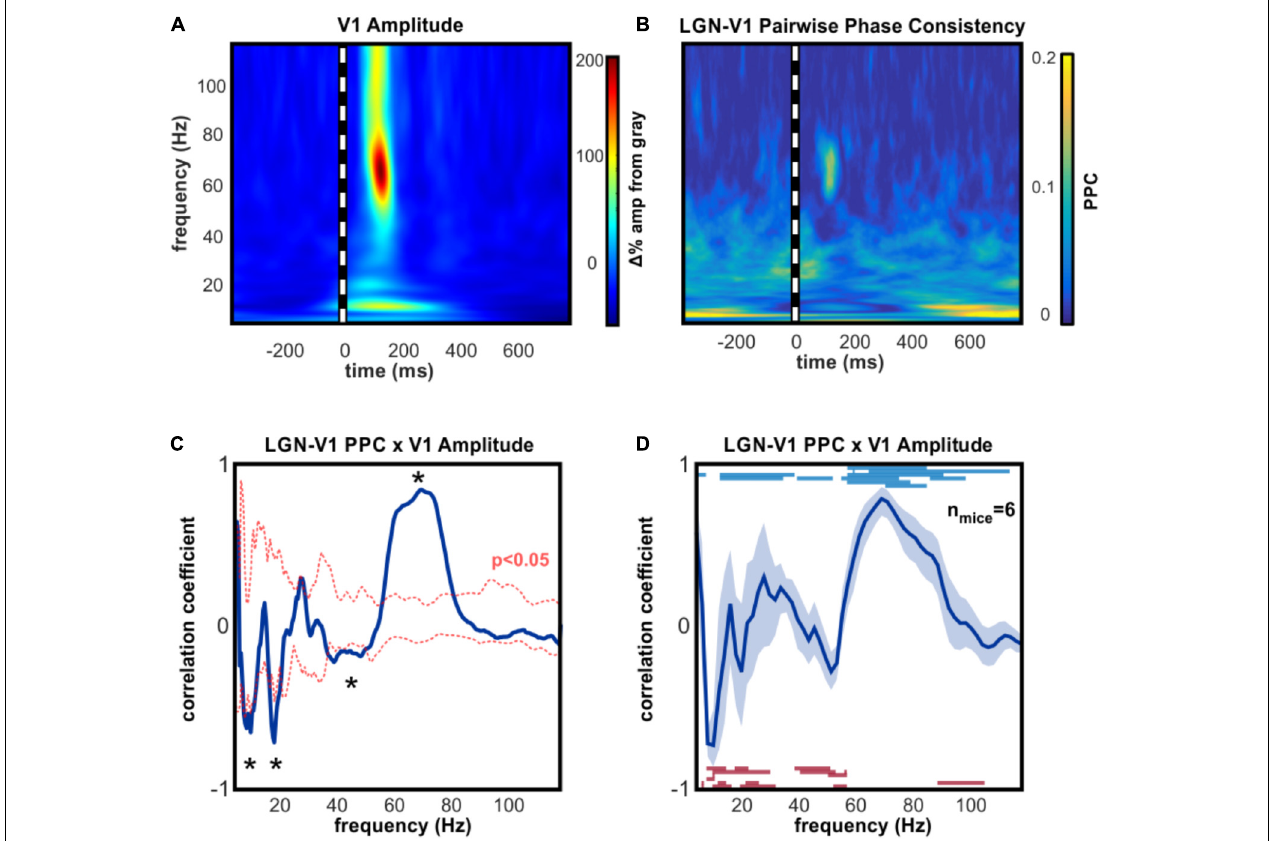
FIGURE 2 | Amplitudeof high gamma V1 oscillations is linked to simultaneous thalamic high gamma. (A) Example time-frequency analysis of V1 LFP, aligned on the presentation of 100 ms full-contrast checkerboard image. (B) Example time-resolved pairwise phase consistency analysis of oscillation phase synchronization between dLGN and V1. PPC is increased in the high gamma frequency range following checkerboard stimulus. (C) Example correlation analysis of (A,B) to identify V1 oscillations whose amplitude is dependent on synchronous thalamic oscillations across stimulus conditions. Asterisks indicate frequencies of significant correlation ( p < 0.05). High gamma in V1 is strongly correlated with synchronous high gamma oscillations in dLGN, and strongly anti-correlated with synchrony in the alpha, beta, and low gamma ranges. (D) Group mean results ( ± SEM) for correlation analysis shown in (C) . Blue lines show frequencies of significant positive PPC-amplitude correlations in individual mice. Red lines show frequencies of significant inverse PPC-amplitude correlation. All animals had significant correlations within the 50–90 Hz high gamma frequency range and significant inverse correlations in the alpha frequency range. At the peak high gamma frequency in V1, dLGN-V1 phase synchronization accounted for an average of 66.9% of the amplitude modulation, across